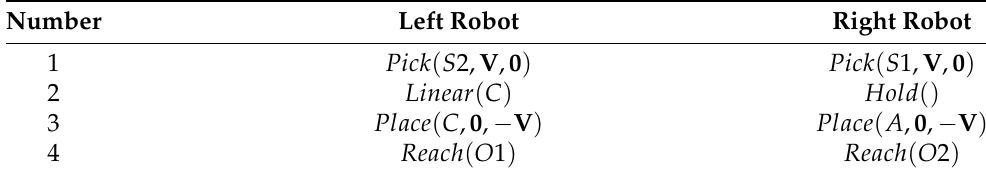
Table 5. Action instructions of dual-robot cooperative disassembling for terminal with wire. Number Left Robot Right